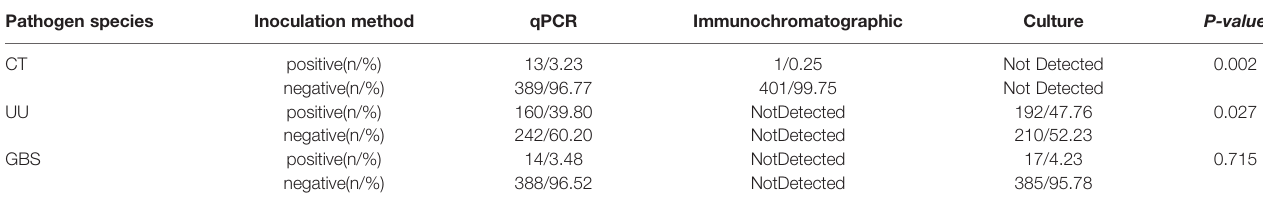
TABLE 3 | Application of Copan-ESwab tubes in the detection of common pathogens in female urogenital tracts via a fl uorescence-based qPCR assay, immunochromatographic and culture.